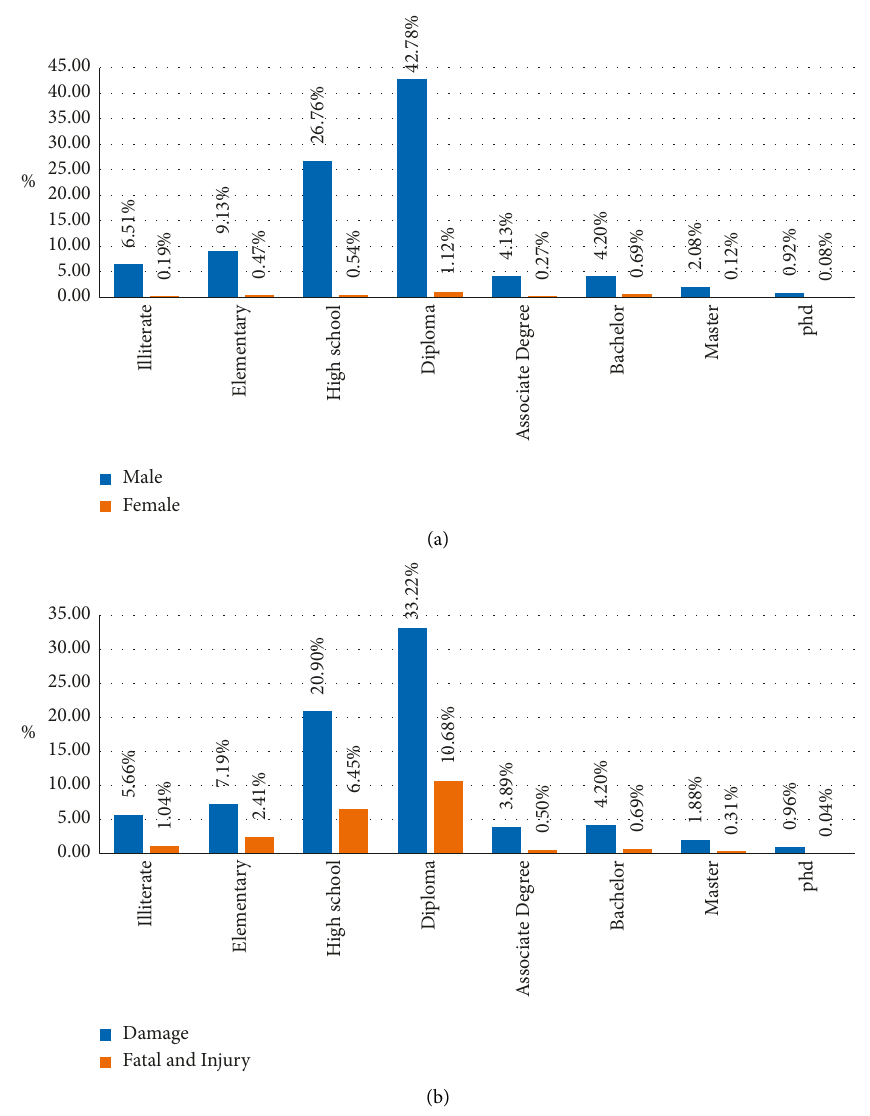
Figure 8: Statistics of vehicle accidents based on education rate: (a) gender of the driver and (b) severity of the